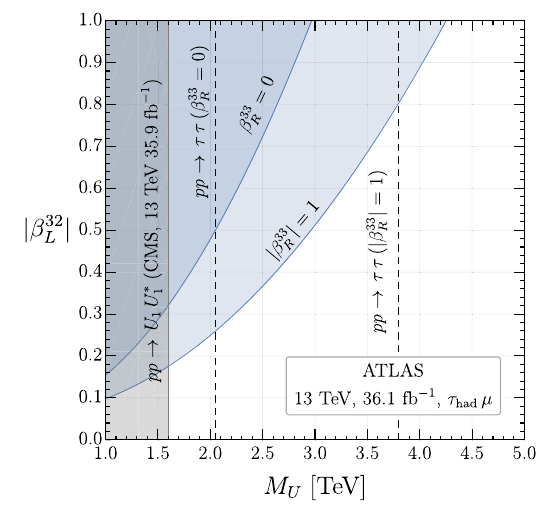
Fig. 7 95% CL exclusion limits from the pp → τμ search. Left: U 1 , M ) plane for different values of the coupling β 33 limits in the (β 32 U L = 1, g = 3 and the leptoquark width to its natural value. We fix β 33 U L